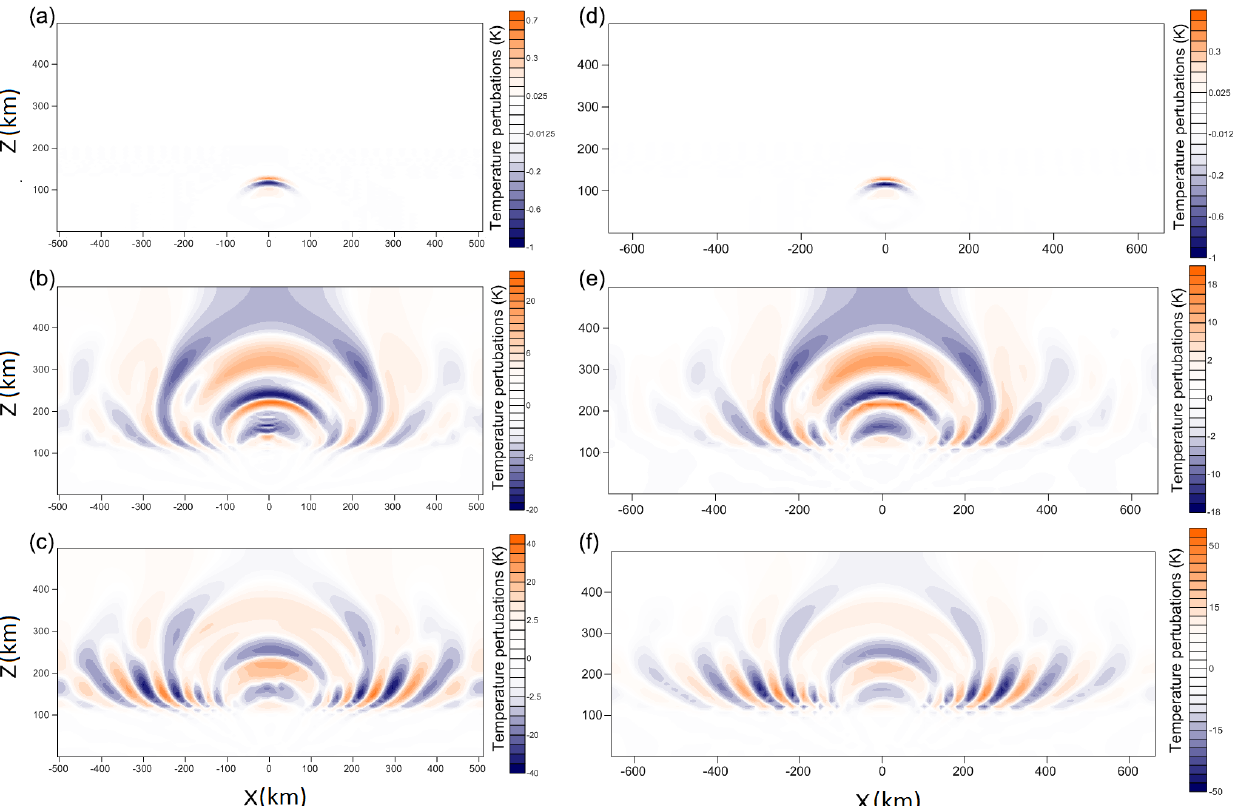
Figure 4. The plane y = 0 of the cross section of the temperature field at (a) t = 7min, (b) t = 40min, and (c) t = 55min for the com- putational area horizontally 1020km × 1020km and the y = 0 cross section of the temperature field at (d) t = 7min, (e) t = 40min, and (f) t = 55min for the computational area horizontally 1320km ×